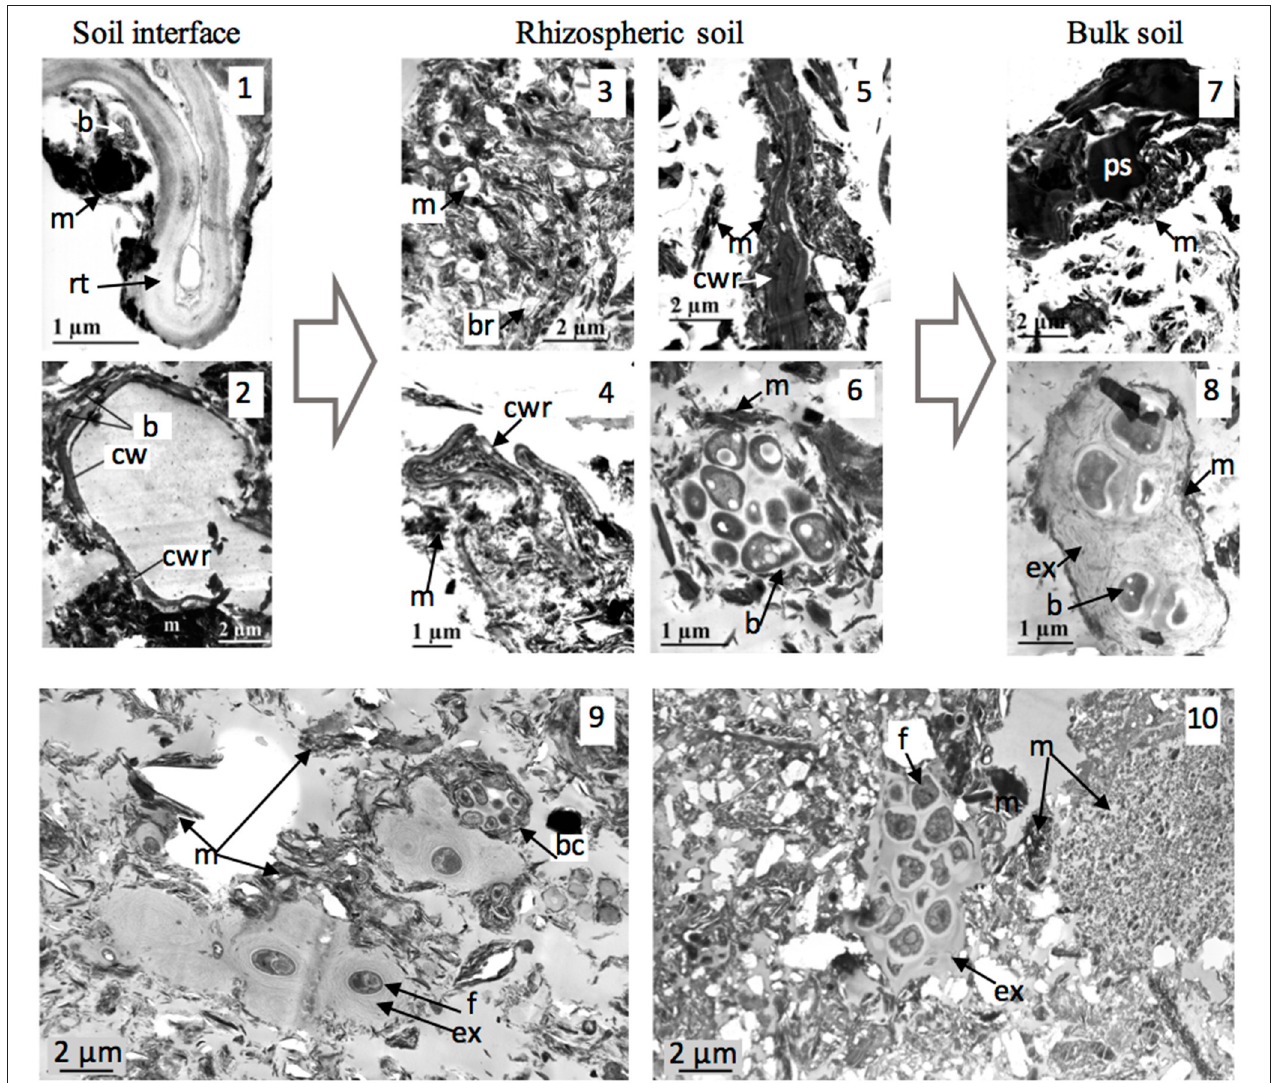
FIGURE 2 | Soil-microorganism interactions at hotspots of biological activity. TEM views (1–8) (soil 4): microaggregation from maize root soil interface (1, 2) to rhizospheric soil (3–6) and to bulk soil (7, 8) (issue from Watteau et al., 2006). (1) Fine root-soil interface; (2) coarse root-soil interface; (3, 4) degradation of root cell walls of fine root forming aggregates; (5) microaggregate with electron-dense root cell wall; (6) bacterial aggregate; (7) microaggegate with electron-dense cell residue; (8) old bacterial aggregate. TEM views (9, 10) : EPS as aggregation agents from bacterial and fungal origin in soil 3 (views 9 ) and in soil 7 (view 10 ). b, bacteria; bc, bacterial colony; br, bacterial residue; cwr, cell wall residue; ex, EPS; m, mineral; ps, polyphenolic substance; rt, root